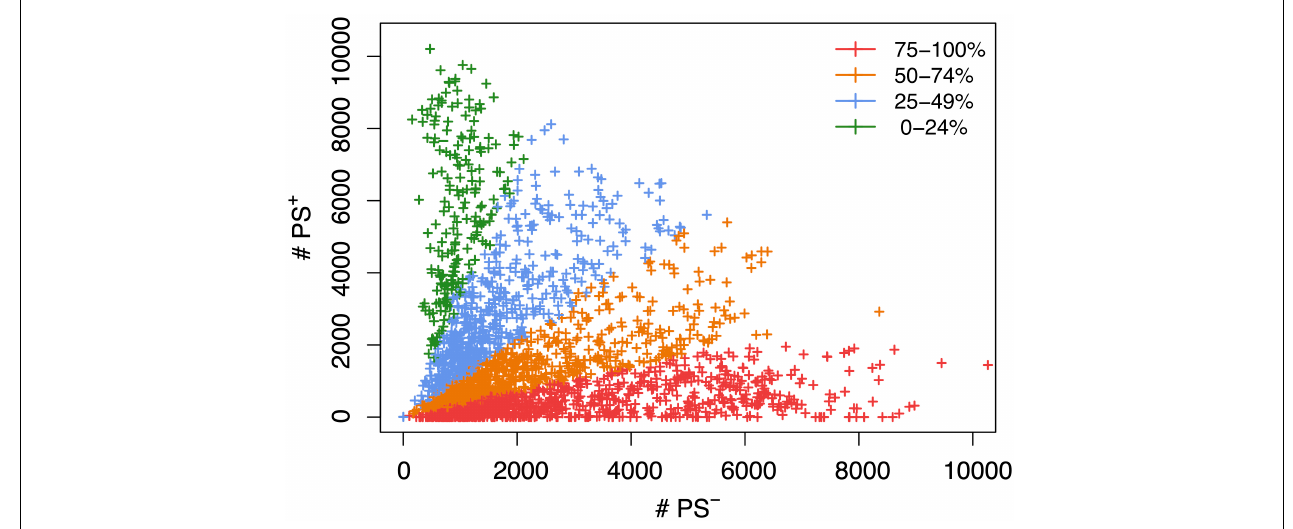
FIGURE 2 | A scatter plot showing the number of candidate haplotype blocks associated with population structure (PS + ) relative to PS - candidate blocks. After 2435 MPD datasets were analyzed by HBCGM, candidate blocks ( p HBCGM < 0 . 01) were analyzed by an association test to determine whether they were related to population structure among the inbred strains that were analyzed. Each datapoint (+) indicates the number of PS + ( y -axis) and PS - ( x -axis) blocks identified for one MPD dataset. There are 949 MPD datasets where 75% to 100% of the blocks are PS - (shown in red); the 711 datasets with 51–74% PS - blocks are shown in orange; and the 565 datasets with 25-49% PS - haplotype blocks are shown in blue; and the 210 datasets with 0–24% PS - blocks are shown in green.